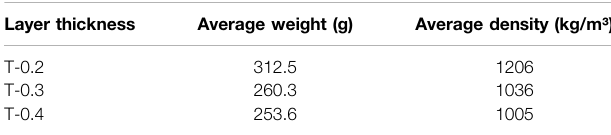
TABLE 1 | Physical properties of specimens with different layer